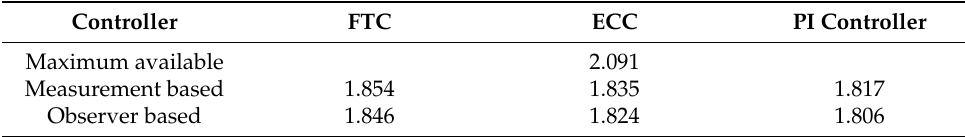
Table 4. Mean available and injected active power